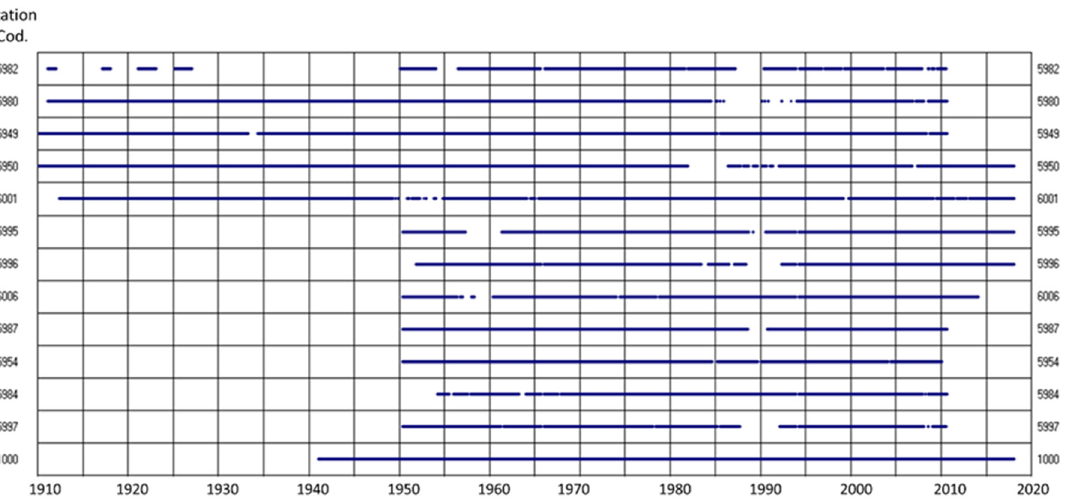
Figure 3. Length of precipitation records from the selected stations prior to their completion with CHAC.